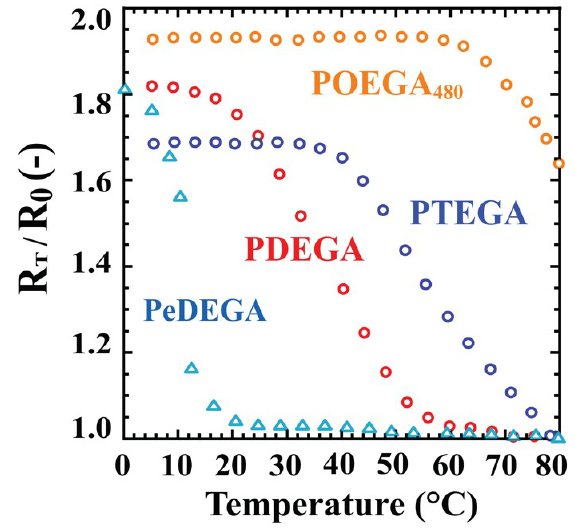
Figure 4. Transition behaviours of POEGA gels in pure water. △ : PeDEGA, 〇 : PDEGA, 〇 : PTEGA, 〇 : POEGA 480 .